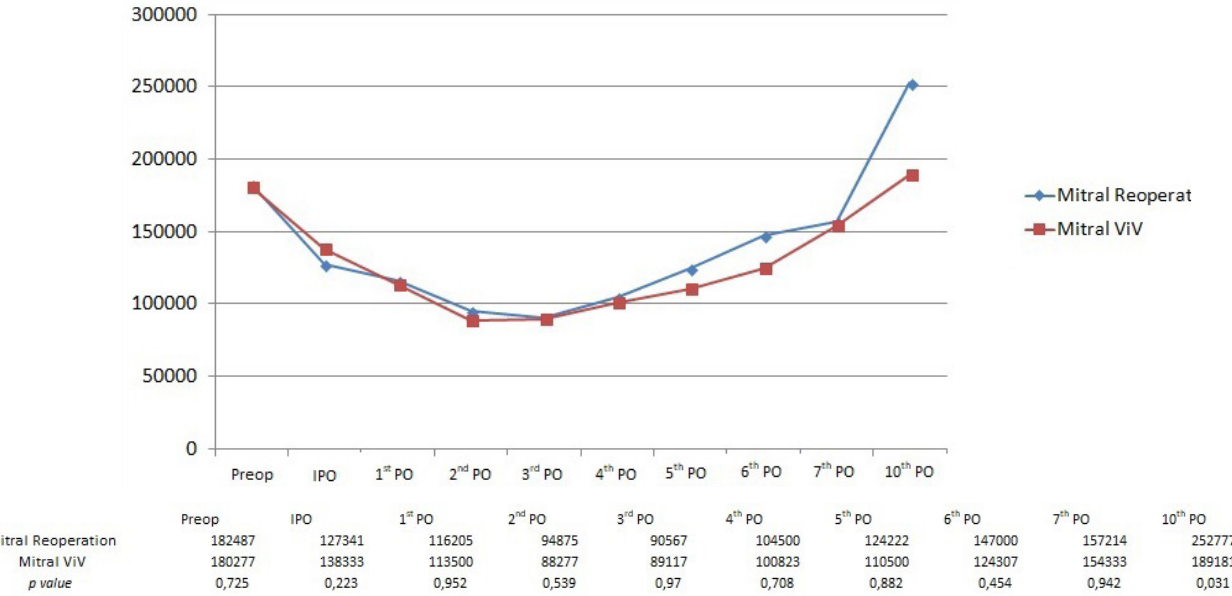
Fig. 2 - Comparison between mean platelet values for conventional mitral reoperation and mitral valve-in-valve (VIV) patients.